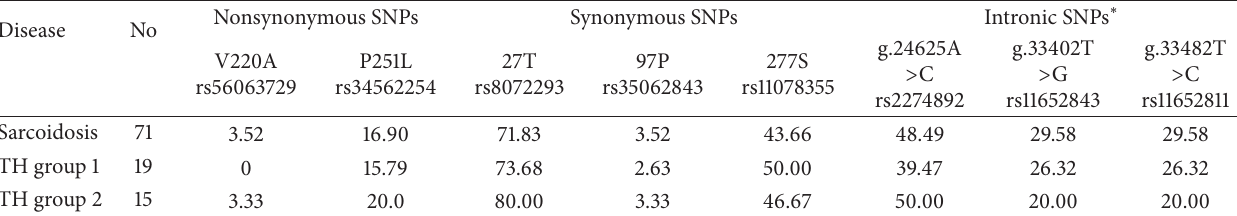
Table 2: Allele frequency (%) of TNFRSF13B/TACI polymorphisms in the patients of the study.